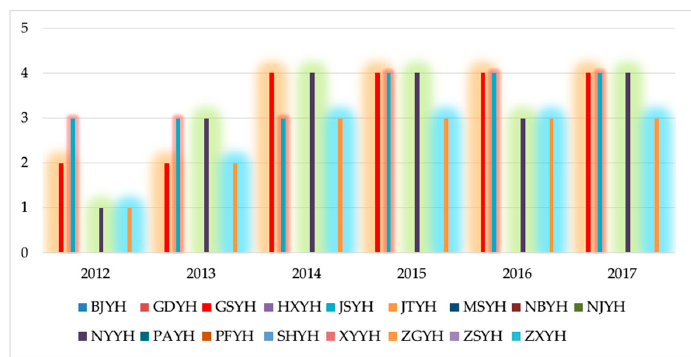
Figure 2. The trends of the inputs and outputs (2012–2017).